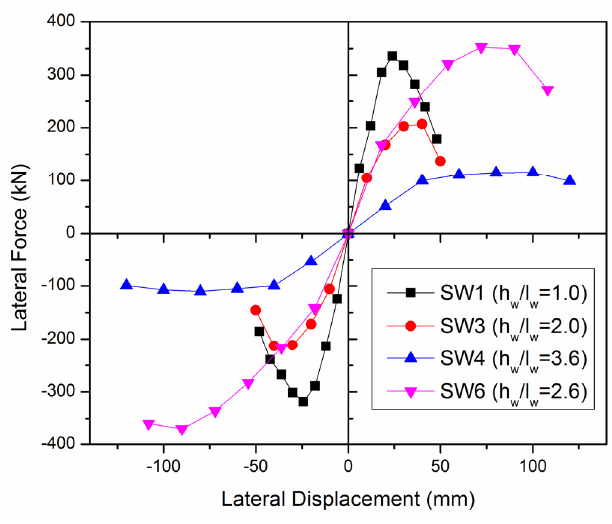
Figure 13. Normalized load-displacement curves for different aspect ratios for SCMSW specimens.